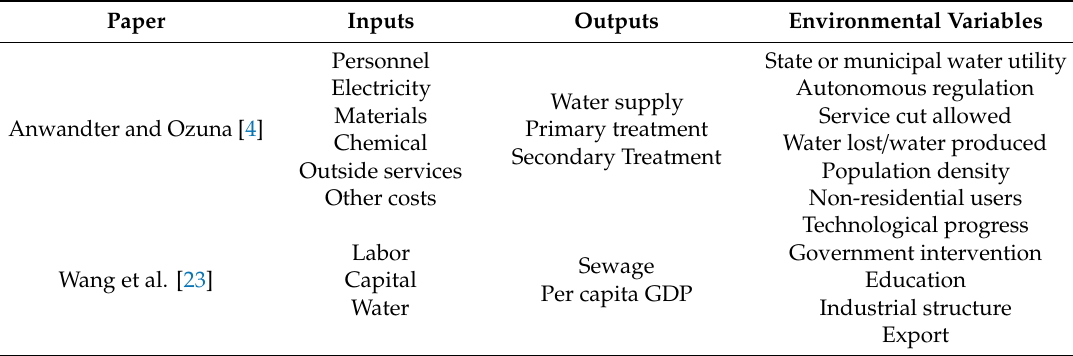
Table 6. Papers using DEA and regression